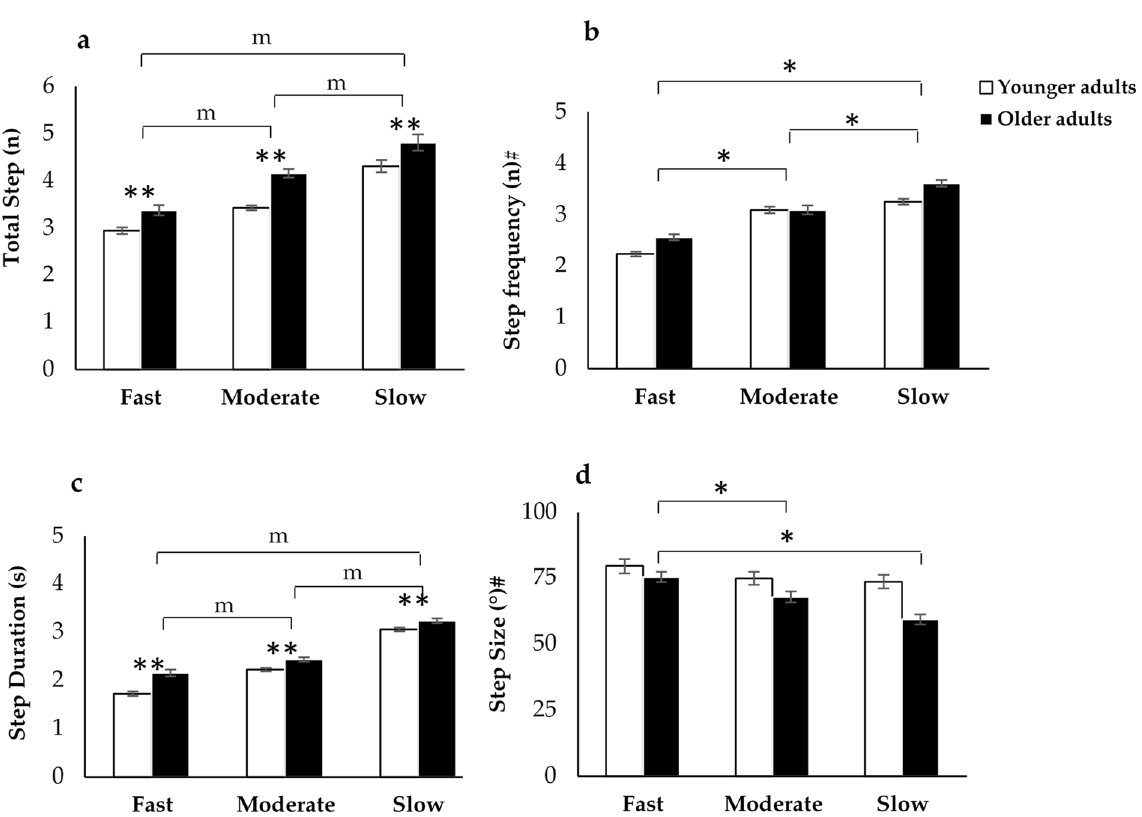
Figure 7. The effect of turn speed on ( a ) total step counts, ( b ) step frequency and ( c ) step duration taken to turn and ( d ) step size. Values are mean ± SEM. # Indicates a significant interaction ( p < 0.05) from MM ANOVA. * Indicates post-hoc pairwise comparisons of turning speeds within group from RM ANOVA. ** Indicate main effects of group and speed from MM ANOVA. m Indicates post-hoc pairwise with a Bonferroni adjustment for multiple comparisons from MM ANOVA.